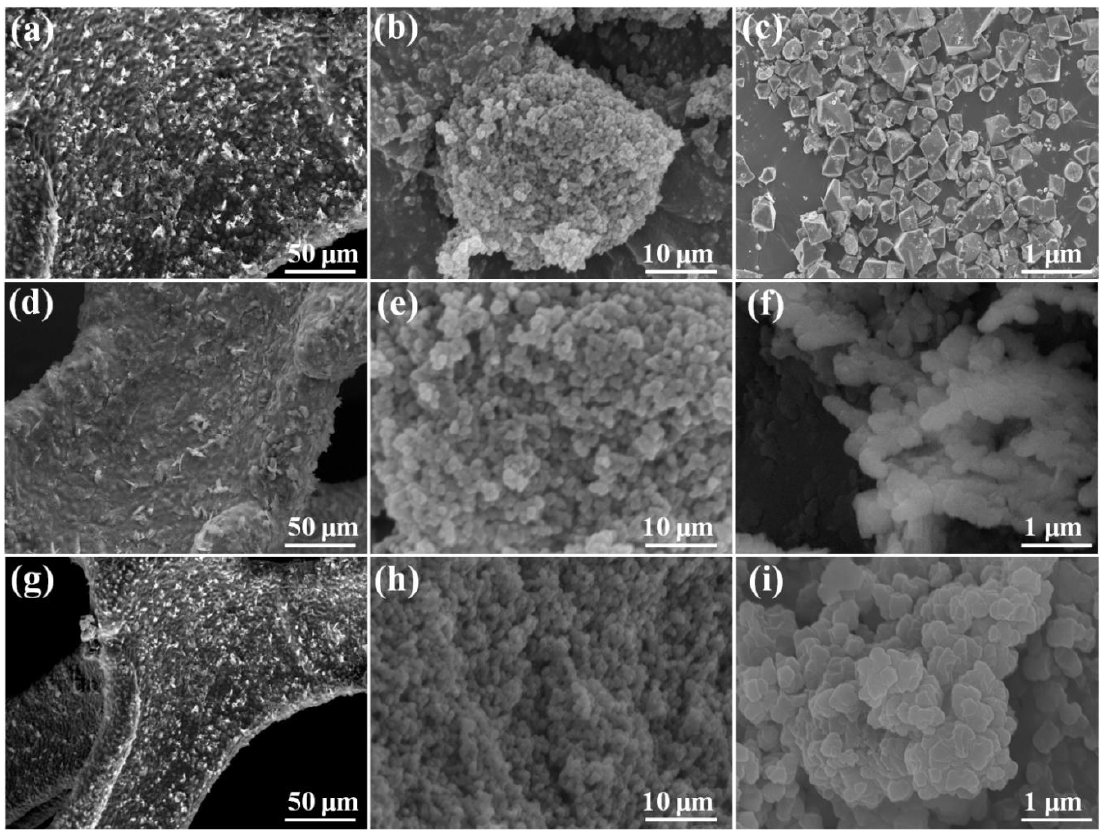
Figure 2. SEM images of the prepared Co(OH) 2 nanoparticles ( a – c ), Ag-doped@Co(OH) 2